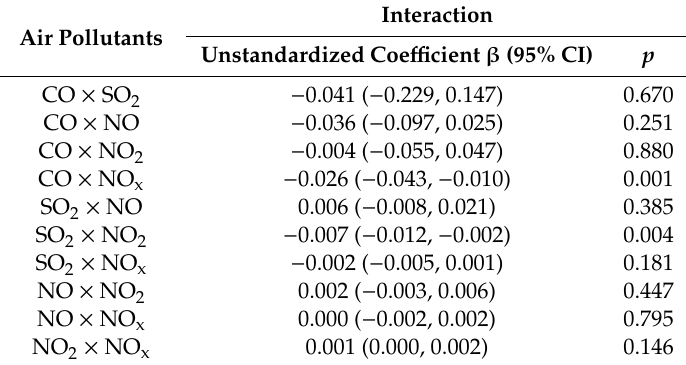
Table 3. The interaction between air pollutants on BMD T-score using generalized linear model.